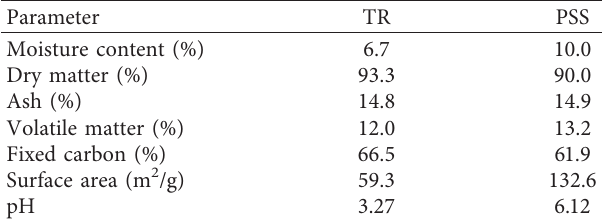
Table 1: Physiochemical properties of